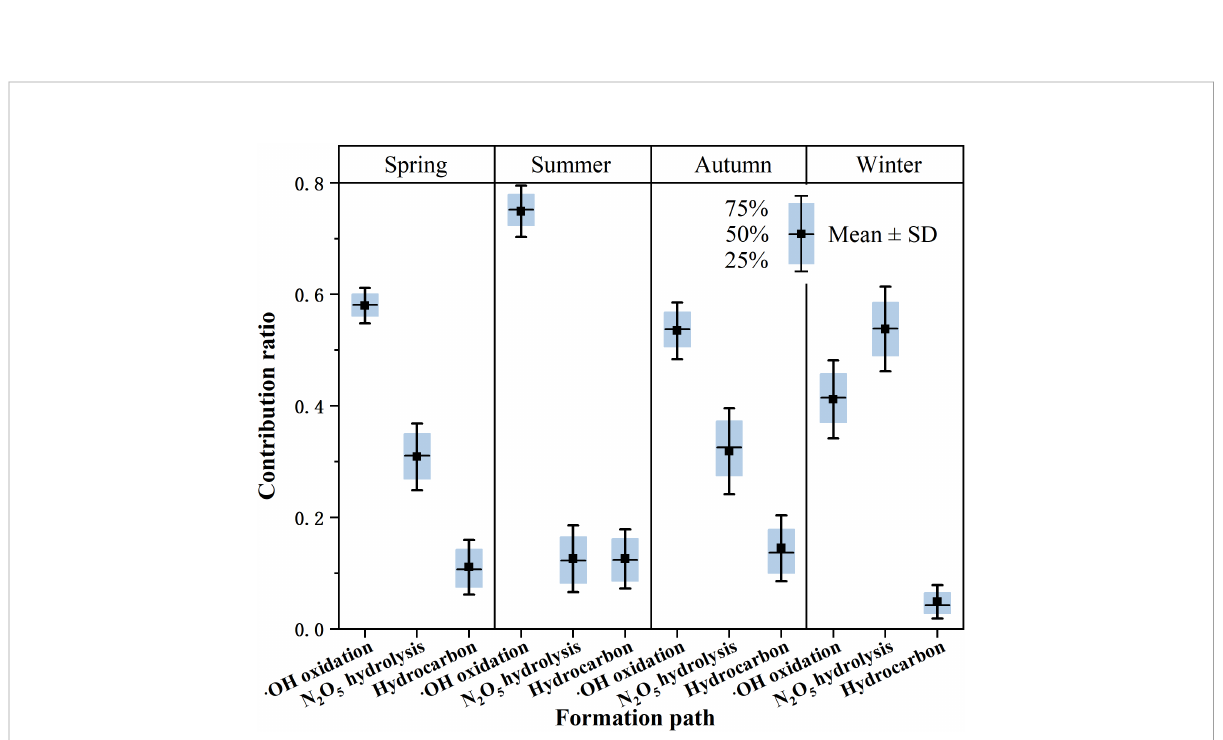
FIGURE 3 Contribution ratios of (cid:129) OH oxidation, N 2 O 5 hydrolysis and hydrocarbon paths for aerosol nitrate in different seasons at the Qianliyan Island.